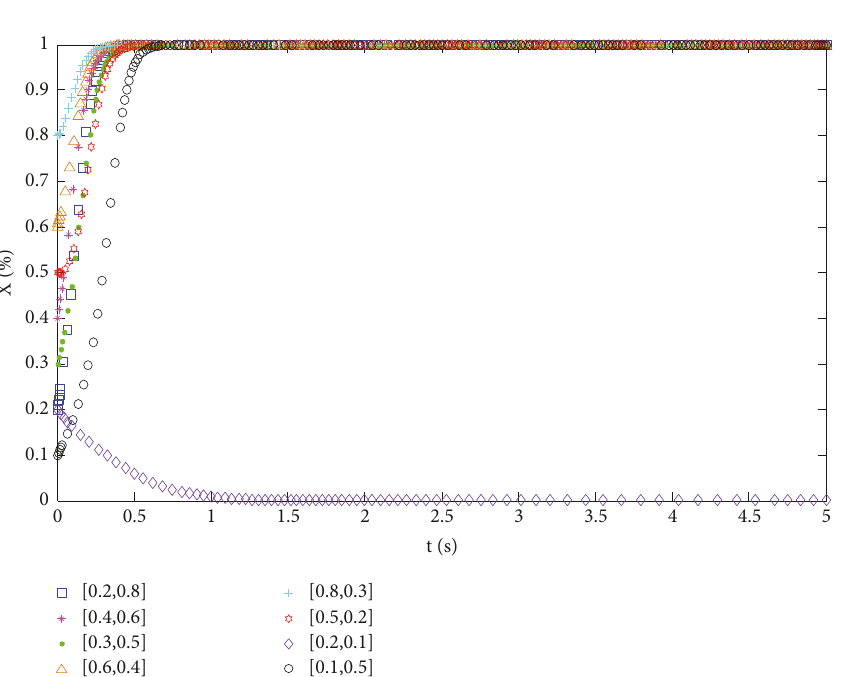
Figure 4: The Y-X type of phase diagram (ESS: D(1,1) & A(0,0)).